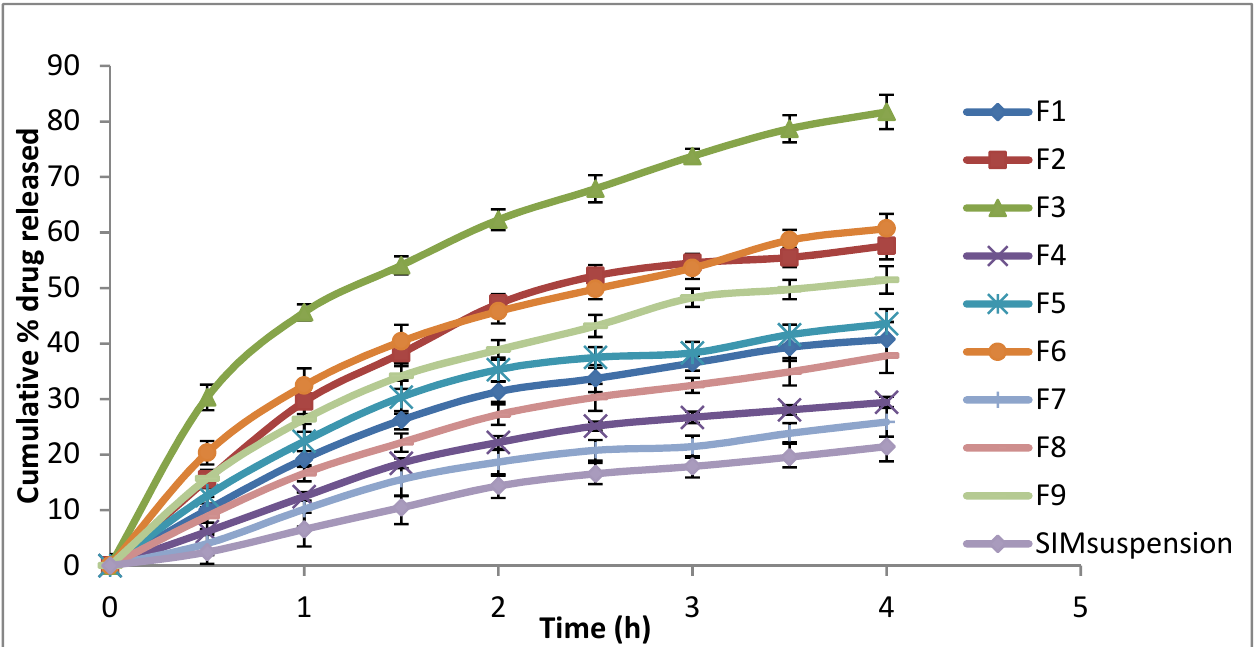
Figure 1. In vitro release pro fi le of di ff erent SIM-loaded cubosomes.